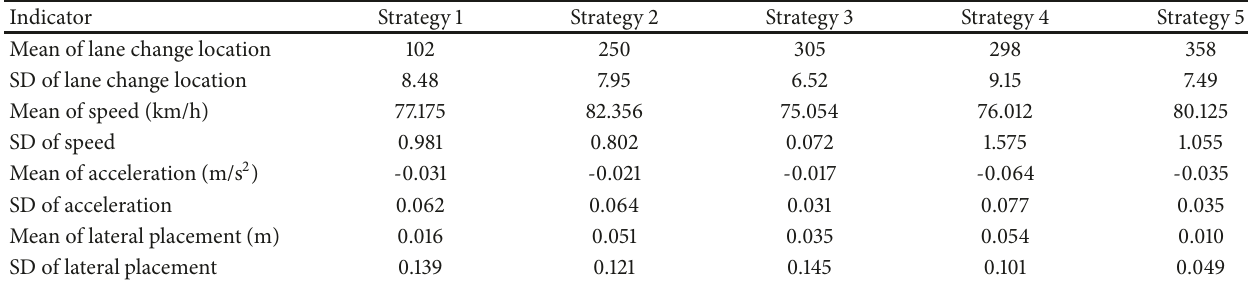
Table 3: Vehicle operating characteristics with respect to the five